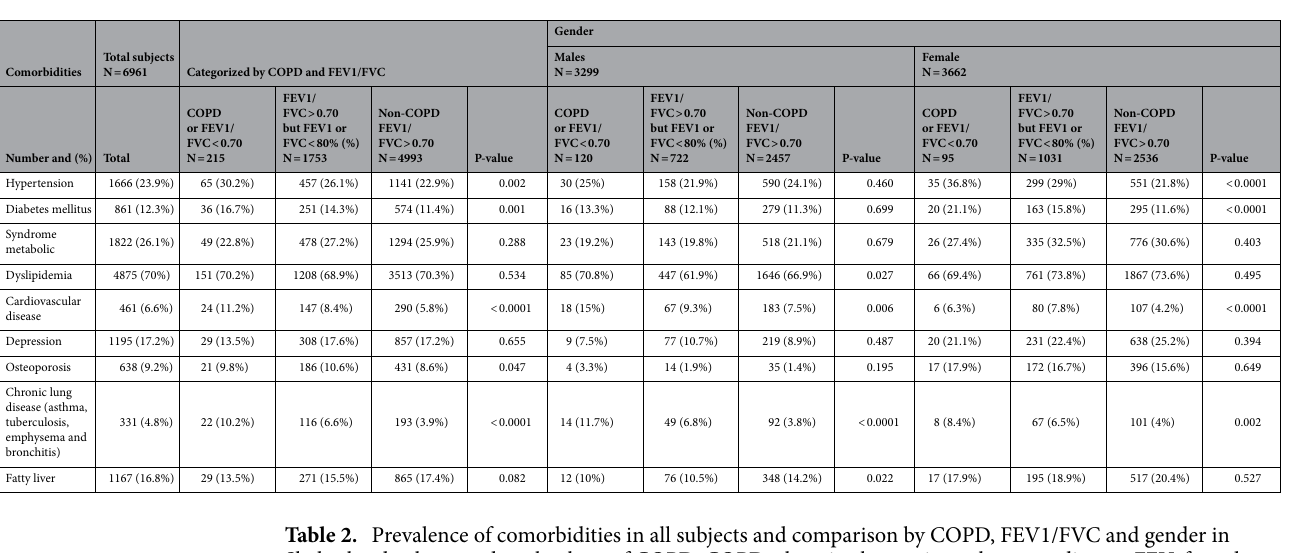
Table 2. Prevalence of comorbidities in all subjects and comparison by COPD, FEV1/FVC and gender in Shahrekord cohort study-subcohort of COPD. COPD: chronic obstructive pulmonary disease; FEV: forced expiratory volume; FVC: forced vital